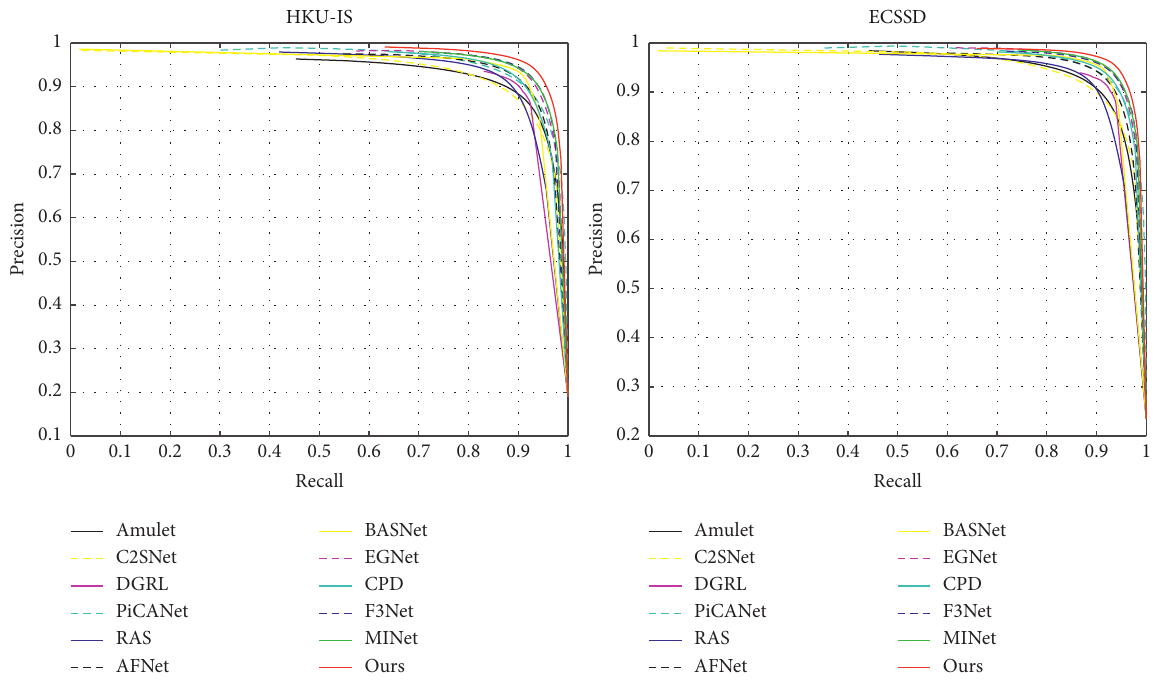
Figure 8: Precision-Recall curves on two common saliency datasets, including HKU-IS and ECSSD.